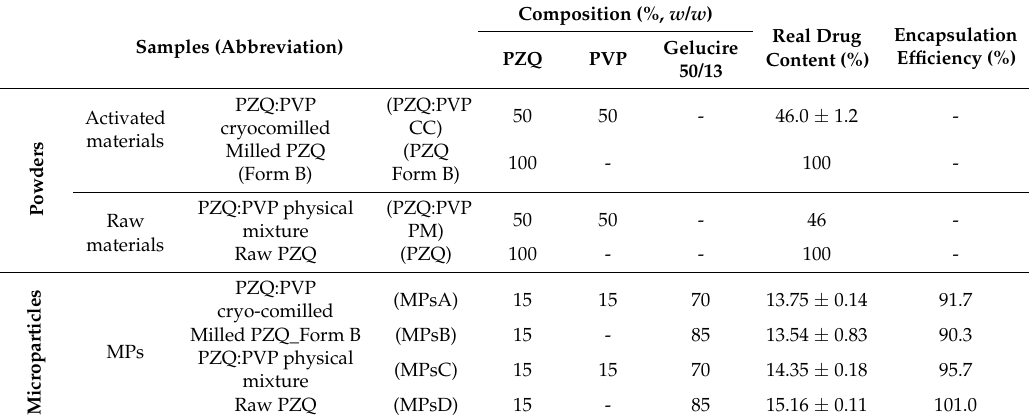
Table 2. List of the analyzed samples, their relative composition and effective drug content.